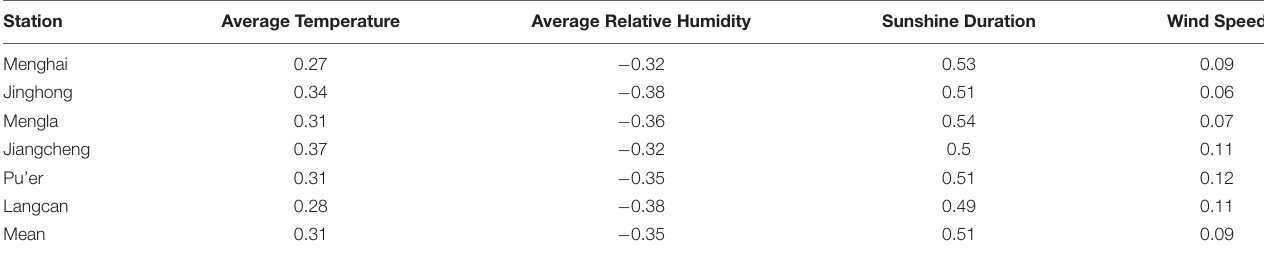
TABLE 5 | Correlation coefficients of ET 0 and meteorological variables. Station